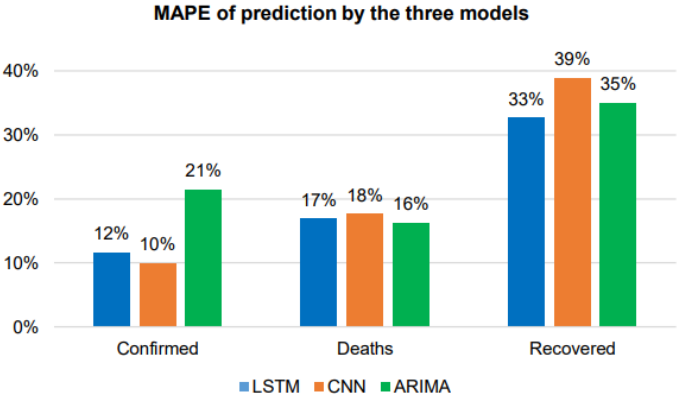
Figure 20. MAPE comparison of the three